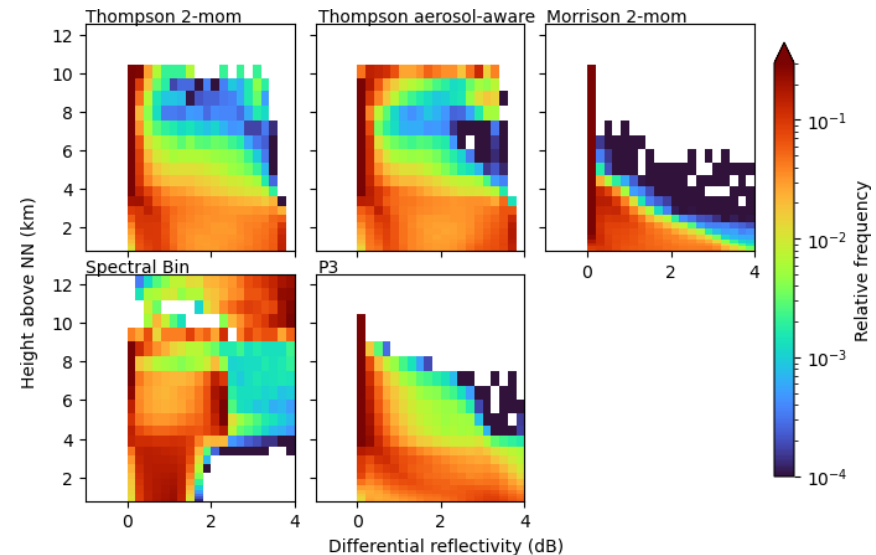
Figure B3. CFADs of simulated differential reflectivity of the rain hydrometeor class over 5 convective days in 2019.